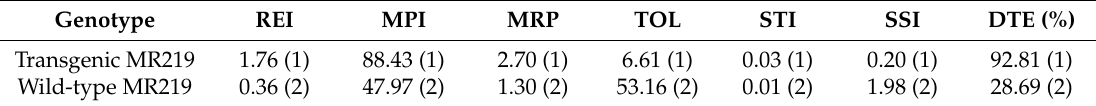
Table 9. The drought tolerance indices of genotypes under drought stress